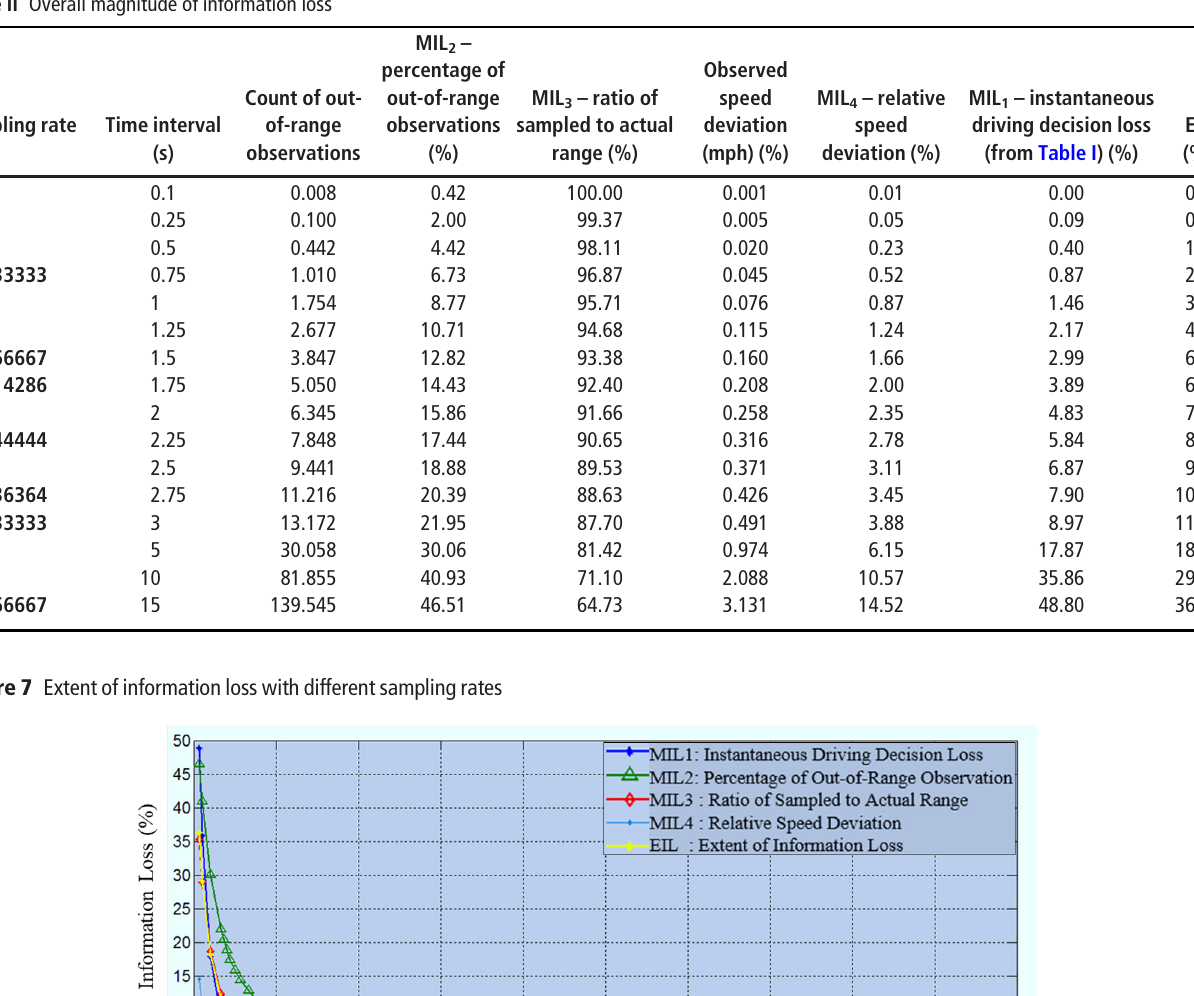
Table II Overall magnitude of information loss